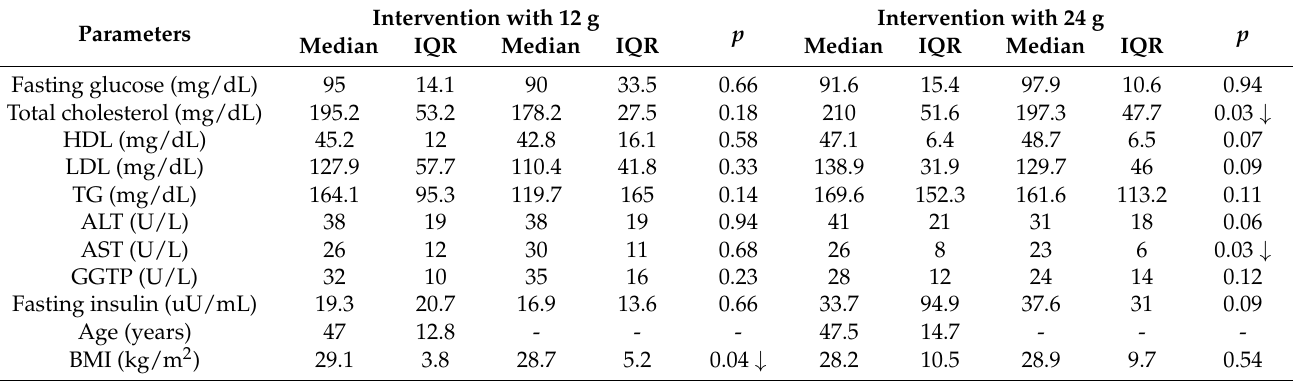
Table 1. Differences between biochemical parameters before and after 8 weeks of high-fiber buns intervention.